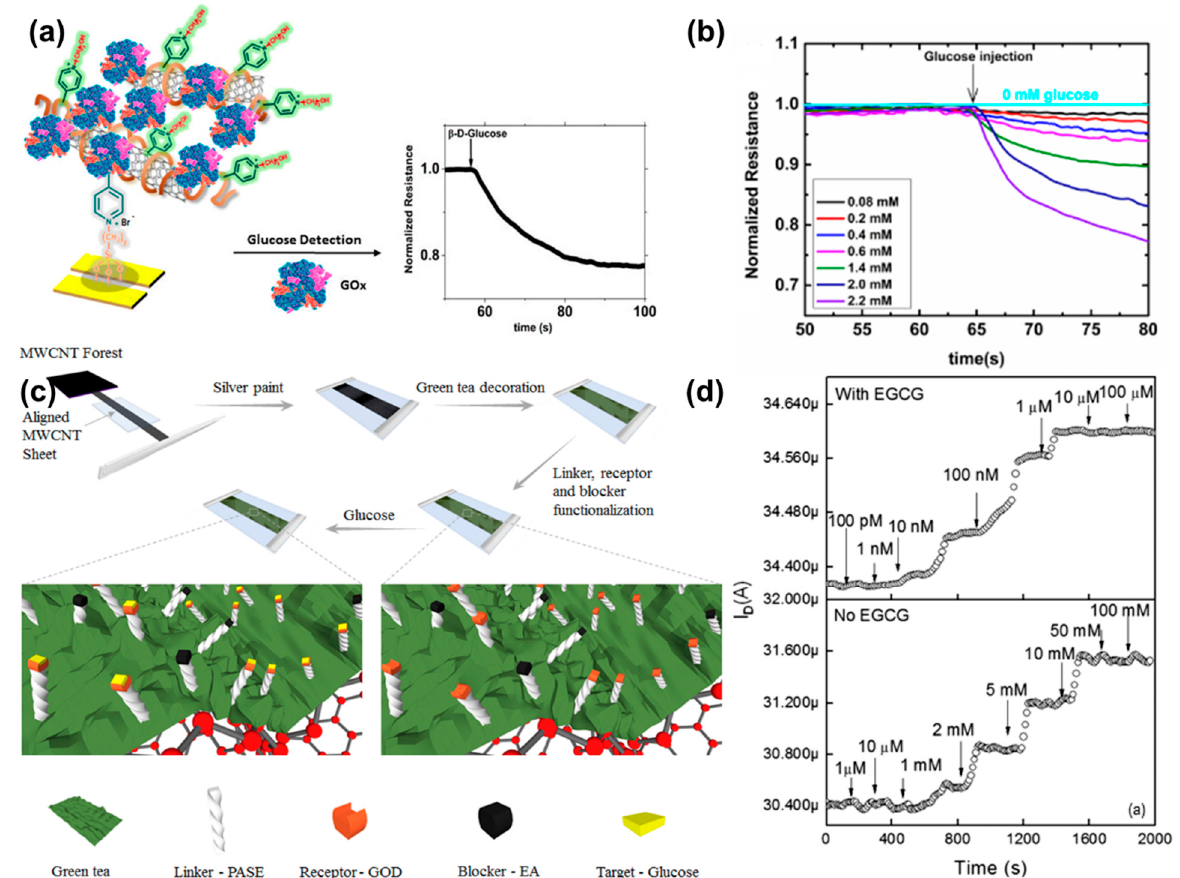
Figure 5. ( a ) A chemiresistive glucose sensor with GOD immobilized on a MWCNT-PVP film. A reduction in resistance is observed when the sensor is exposed to the glucose concentrations. Reprinted with permission from [19]. Copyright 2017 American Chemical Society. ( b ) Normalized resistance change of the sensor shown in Figure 5a, when it is exposed to glucose concentrations ranging from 0.08 mM to 2.2 mM. Reprinted with permission from [19]. Copyright 2017 American Chemical Society. ( c ) Schematics showing the steps for sensor fabrication with green tea and MWCNT and GOD. Reprinted from [49] with permission from Elsevier. ( d ) The current response for the sensor depicted in Figure 5c with and without EGCG. Reprinted from [49] with permission from Elsevier.